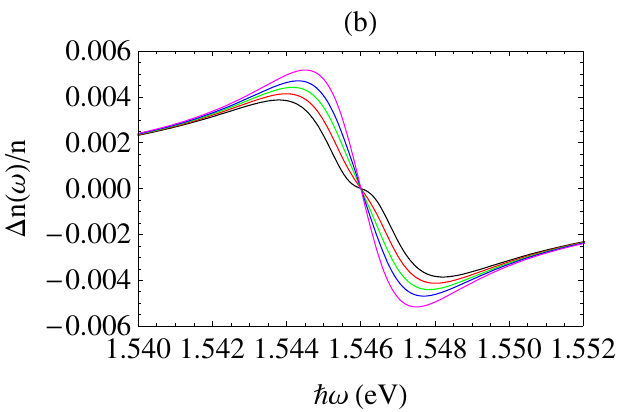
∆ n ∆ n ( ω , I , d ) tot ( ω , I , d ) Figure 3. (Color online) The RIC ( a ) and ( b ). The various curves are for different n n distances from the surface of the metallic nanoparticle: d = 80 nm (black curve), d = 15 nm (red curve), d = 10 nm (green curve), d = 7.5 nm (blue curve), and d = 5 nm (magenta curve). The intensity is I = 9 × 10 9 W/m 2 and the electric field is polarized along the z